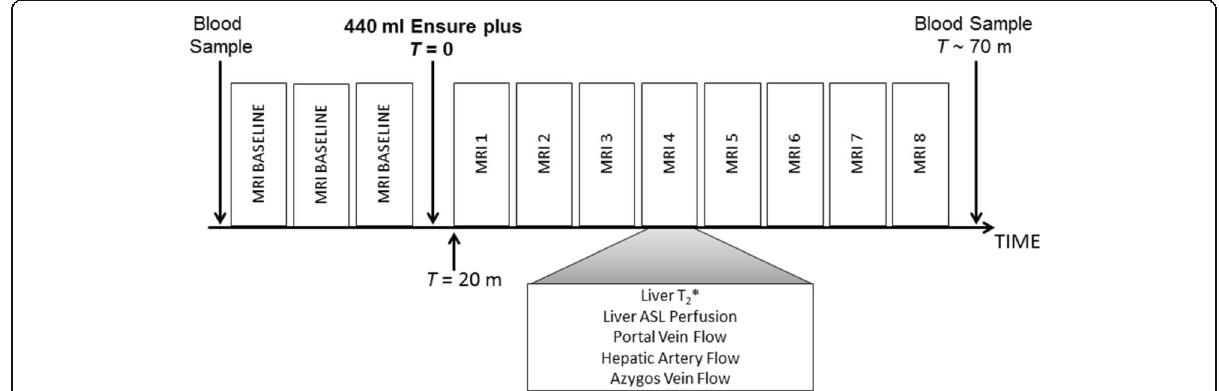
Fig. 1 Magnetic resonance imaging (MRI) protocol comprising serial measurements. Measurements were collected in triplicate at baseline and then repeated from time ( T ) = 20 – 65 min following meal ingestion. Measurements were collected to assess blood flow to the liver and collateral flow (using phase contrast sequences), liver tissue perfusion (using the arterial spin labelling (ASL) technique) and liver transverse relaxation time (T2*), an indirect marker of